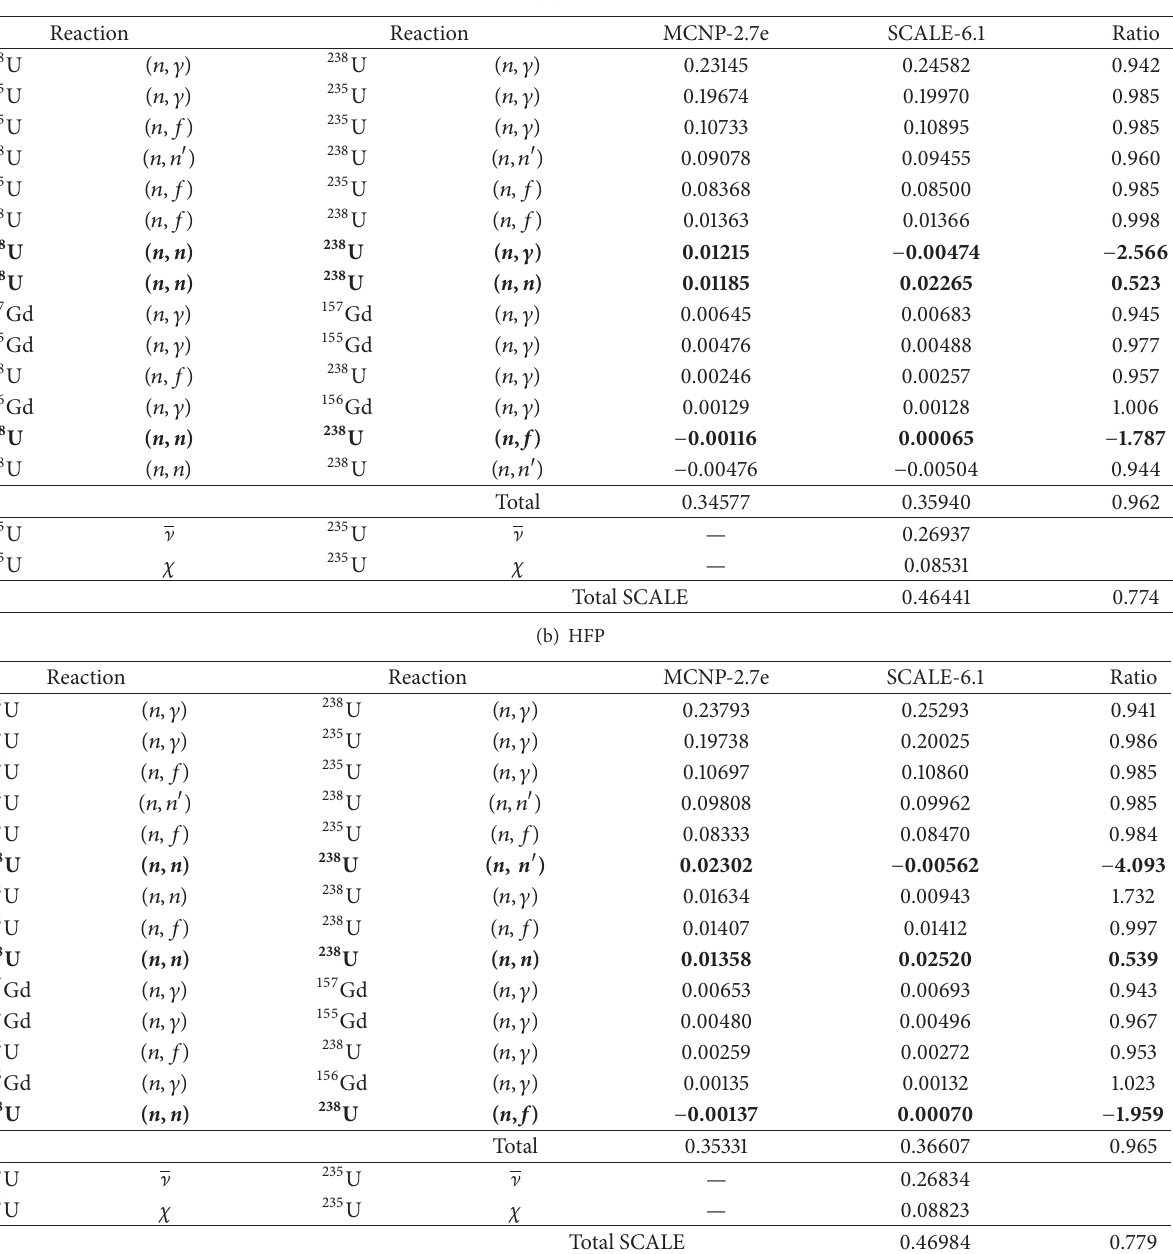
Table 3: Comparison of the uncertainty contribution to 𝑘 of each variance-covariance matrix of the reaction pair presented in the first two eff columns given in rel.std.dev.(%) calculated by SCALE-6.1 and MCNPX-2.7e for unrodded